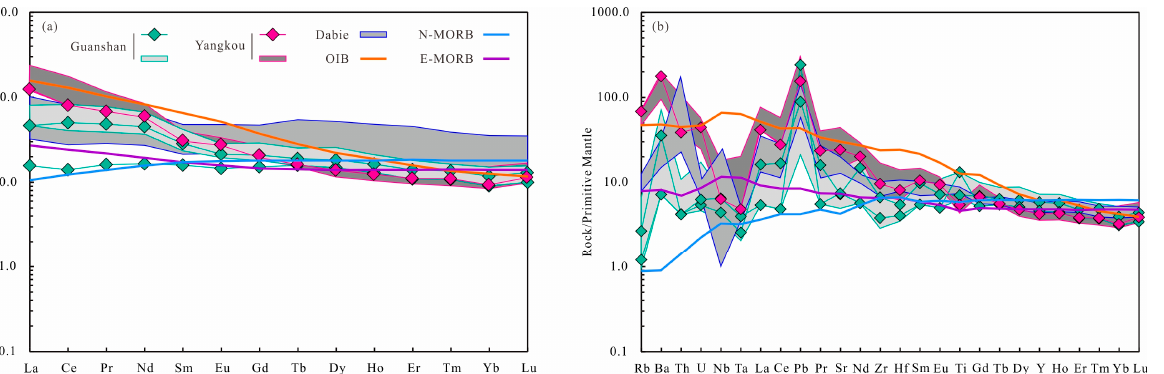
Figure 4. ( a ) Chondrite-normalized rare earth element patterns and ( b ) Primitive mantle-normalized trace element patterns for eclogites from the Guanshan and Yangkou area. Chondrite, primitive mantle, N-MORB, E-MORB and OIB are from Sun and McDonough [44]. Shaded areas of Yangkou are from Yuan et al. [13] and Guanshan are from our unpublished data.